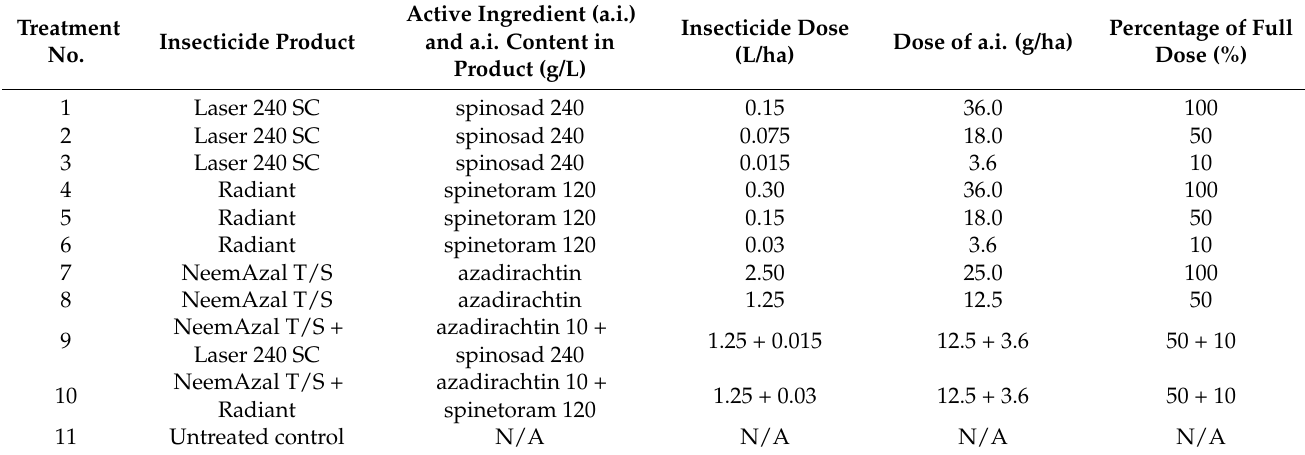
Table 2. Insecticidal treatments used against Colorado potato beetle larvae in the field trial, Zagreb, 2019. Treatment